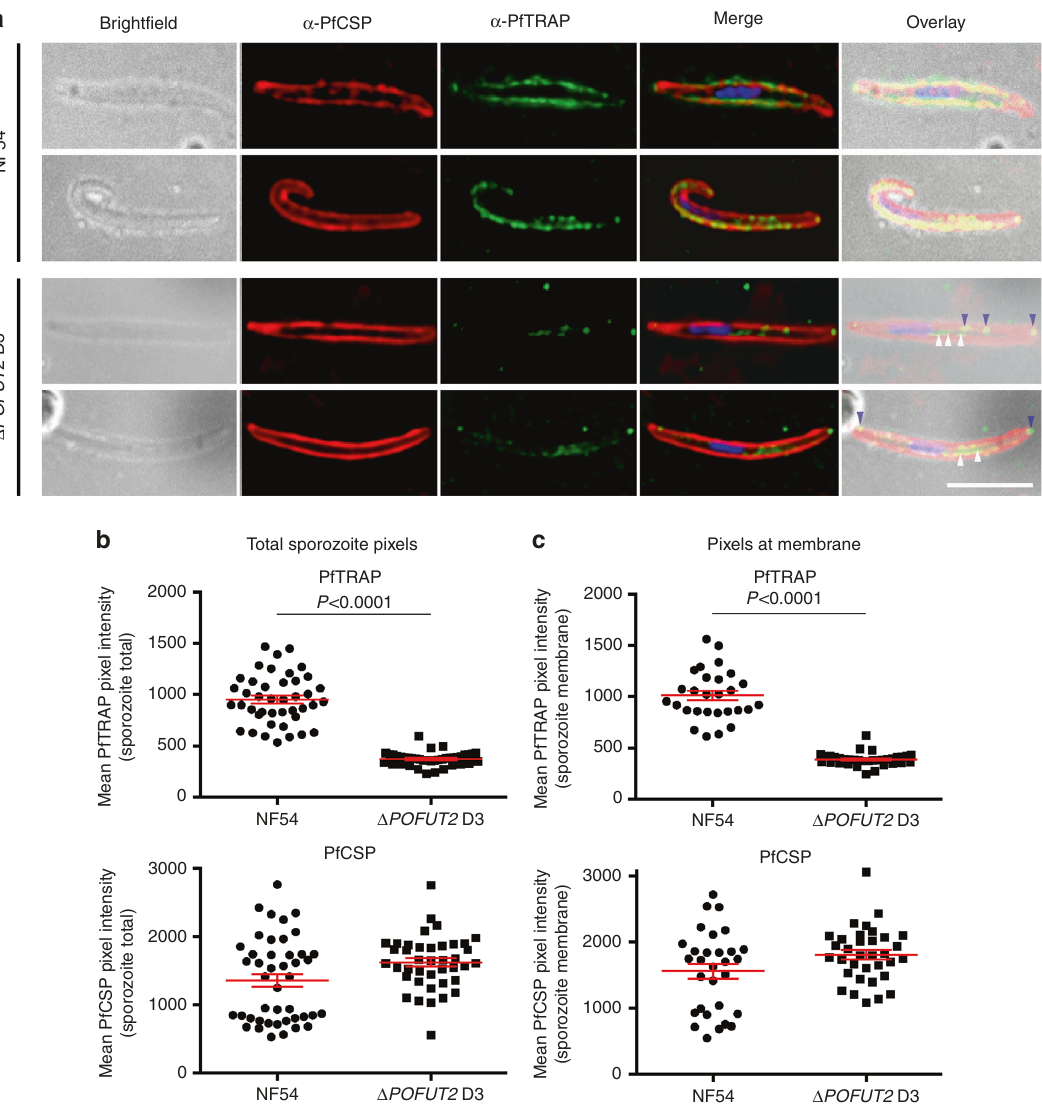
Fig. 4 POFUT2 plays a role in TSR protein traf fi cking in P. falciparum . a Immuno fl uorescence microscopy of NF54 and Δ POFUT2 salivary gland sporozoites showing the localization of CSP ( red ), TRAP ( green ), and dsDNA ( blue ). Purple arrow , TRAP at the sporozoite membrane; white arrow , TRAP internal to parasite. Scale 5 μ m. b Total sporozoite pixel intensity for PfTRAP and PfCSP. c Pixel intensity for PfTRAP and PfCSP at the sporozoite membrane only. Data in b , c is the mean ± S.E.M. from two independent experiments. In panel b , a subtle increase in total PfCSP pixels was observed in Δ POFUT2 D3 relative to NF54 ( P = 0.0360) but no difference was observed at the sporozoite membrane ( P = 0.1083) in panel c . P -values are for one mutant